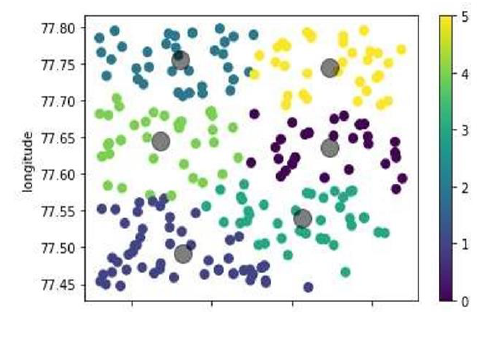
Figure 10. Cluster number=6